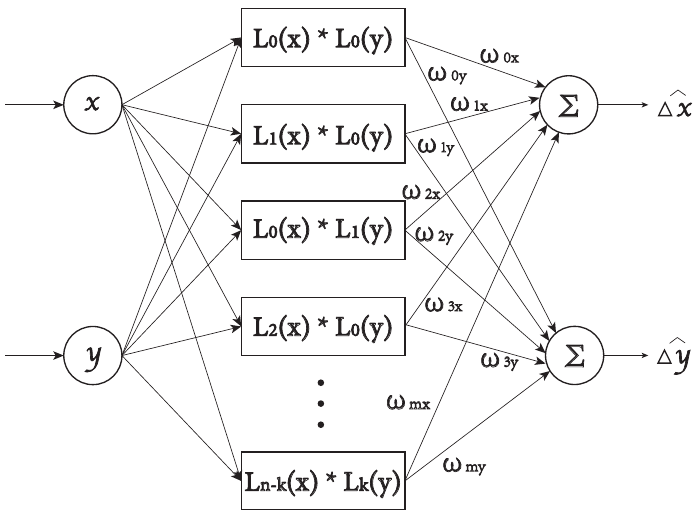
Figure 4. The structure of the Legendre neural